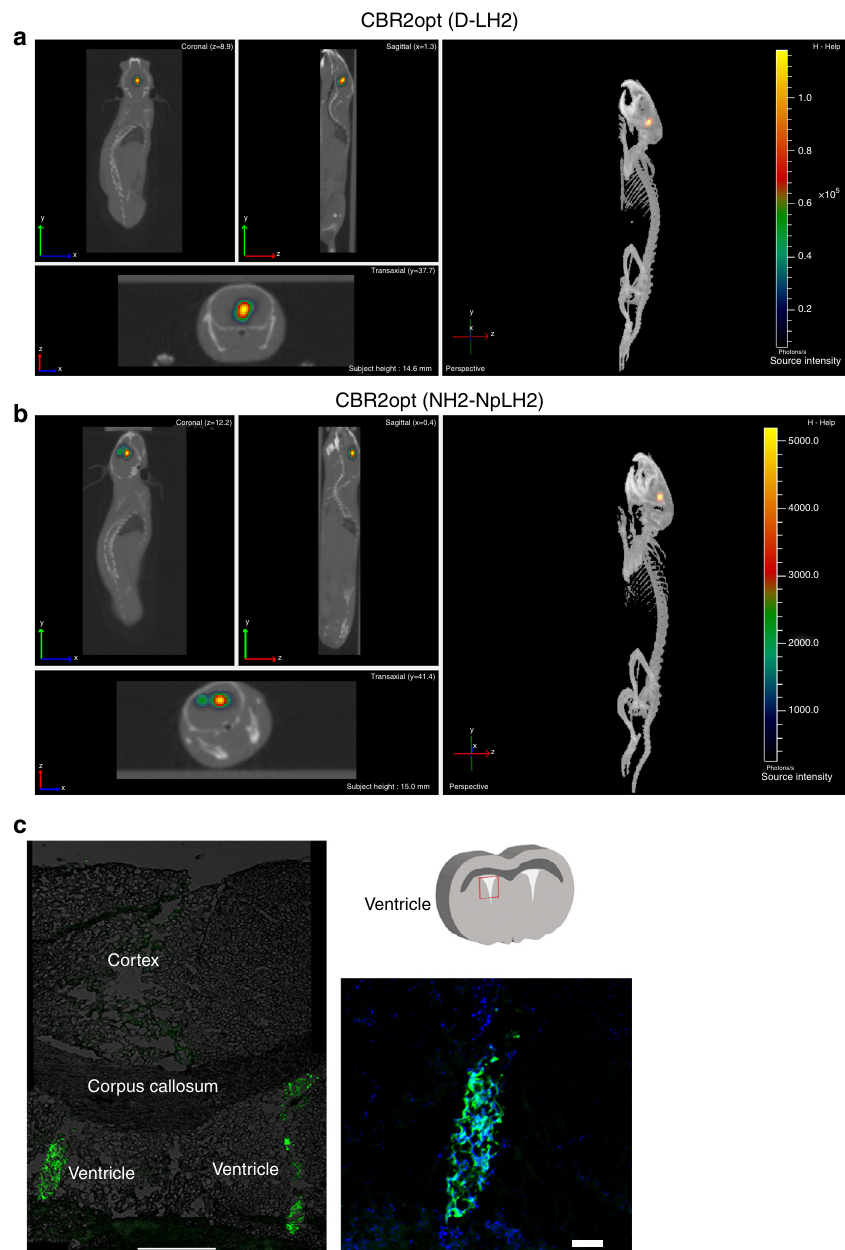
Fig. 6 Bioluminescence tomography in mouse brain showing the location of the bioluminescence signal at day 5 after transplantation of cells. The images were acquired after intraperitoneal injection of NH 2 -NpLH2 (220 mg kg − 1 ) or D-LH2 (300 mg kg − 1 ) using respectively band pass fi lters 700 nm, 720 nm, and 740 nm or 580 nm, 600 nm, and 620 nm for each mouse. Acquisition time was 30 s. After BLI mice kept in the dedicated coil were placed in the CT scanner. a Coronal, transaxial and sagittal view of co-registered CT and BLT images using CBR2opt/D-LH2 pairing. b Coronal, transaxial and sagittal view of co-registered CT and BLT images using the CBR2opt/NH 2 -NpLH2 pair. Migration of cells can be clearly seen at day 5 (two adjacent light sources are represented). c Histological analysis showing the presence of two groups of cells (copGFP) in both ventricular areas of brain (green signal = copGFP; blue = nuclei). Scale bars = 500 μ m (left panel) and 10 μ m (right